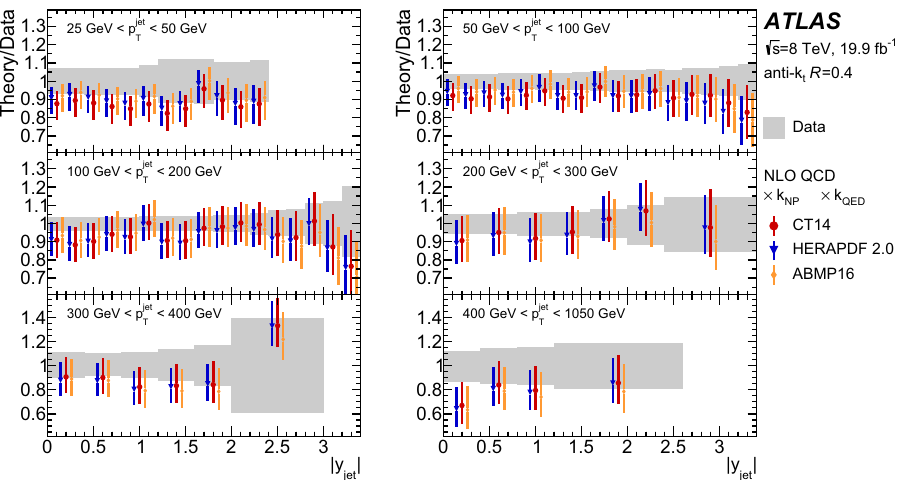
Fig. 14 Ratio of the measured Z + jets production cross-section and the NLO QCD predictions, obtained using MCFM, corrected for the non-perturbative and QED radiation effects as a function of | y jet | and p jet bins. Theoretical predictions are calculated using various PDF sets. T